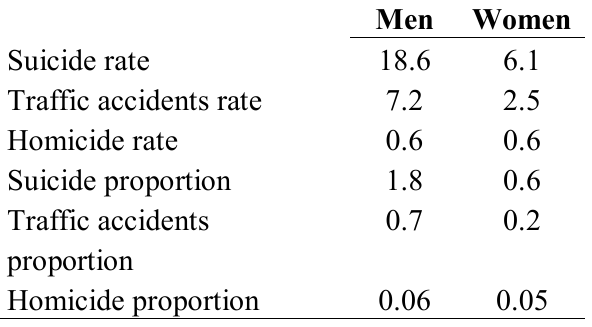
Table 1. Overall event rates (per 100,000 inhabitants) and proportions (per 100 deaths of all death causes) of suicide, traffic accidents, and homicide deaths in Germany